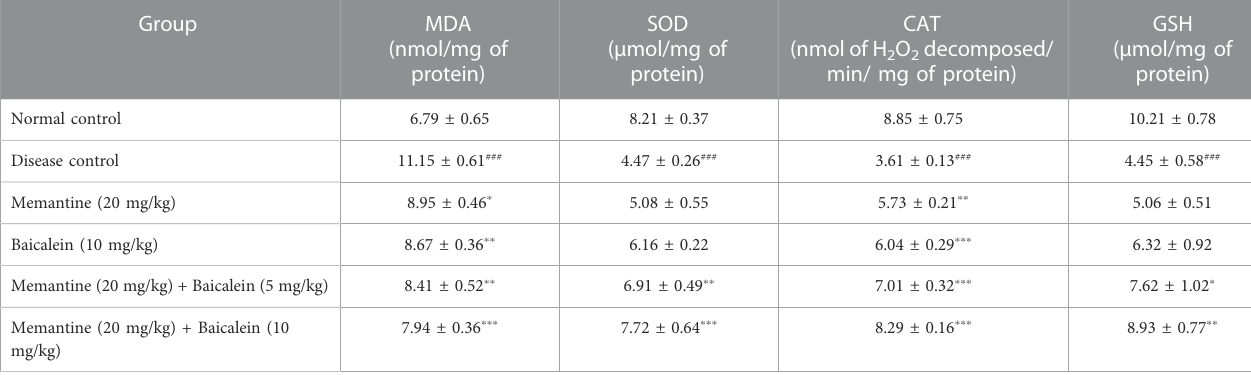
TABLE 2 Effect of baicalein and baicalein with memantine on oxidative stress parameters in cortex.